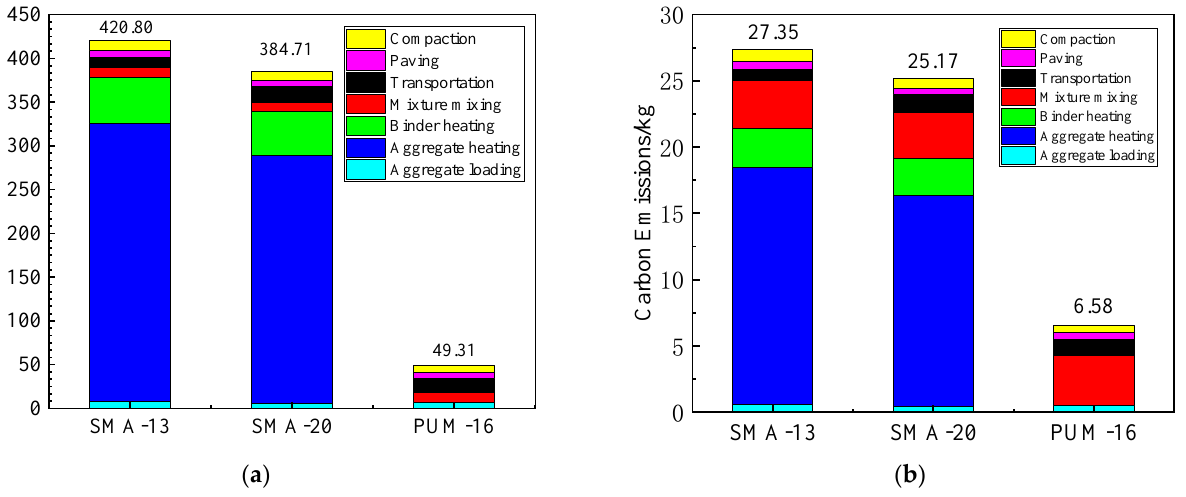
Figure 13. Energy consumption and carbon emissions of pavement construction. ( a ) Energy consumption; ( b ) Carbon emissions.